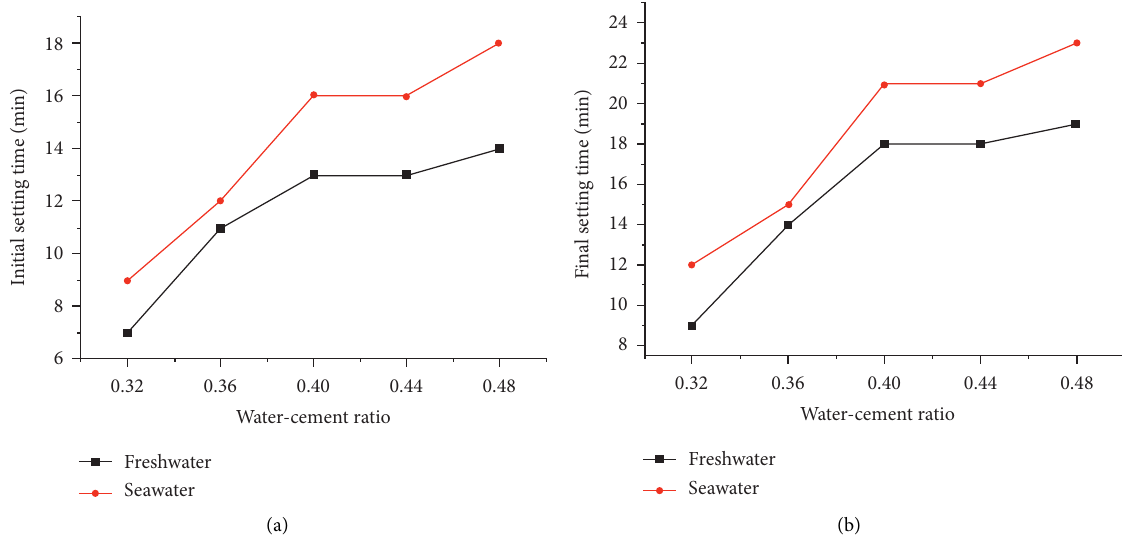
Figure 3: Influence curves of w/c ratio and mixing water on the setting time of CSA cement. (a) Initial setting time. (b) Final setting